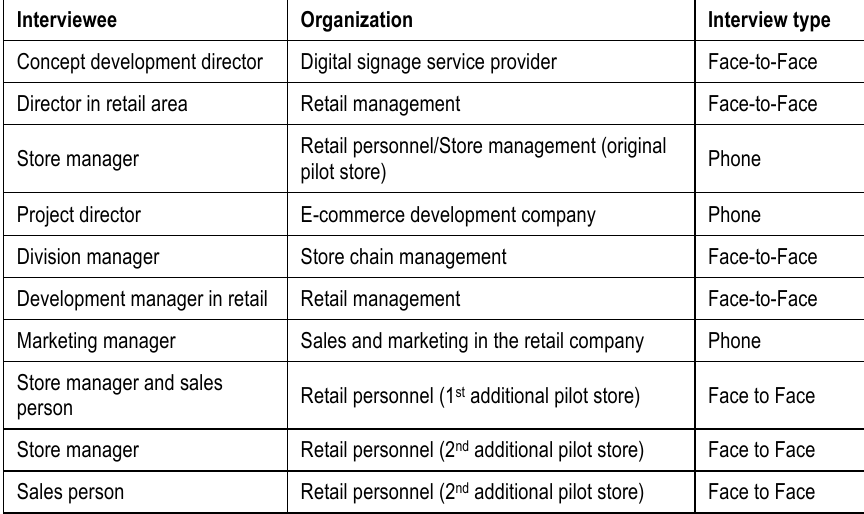
Table 1. Interviewed ecosystem business